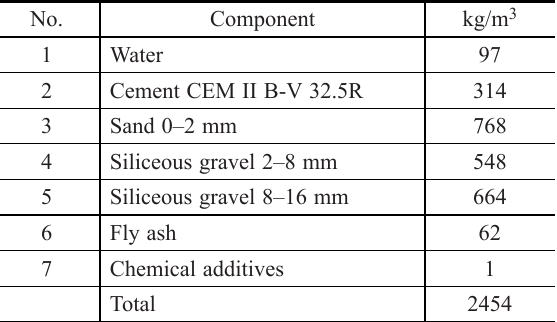
Table 1. Concrete mixture (for 1 m 3 of concrete)